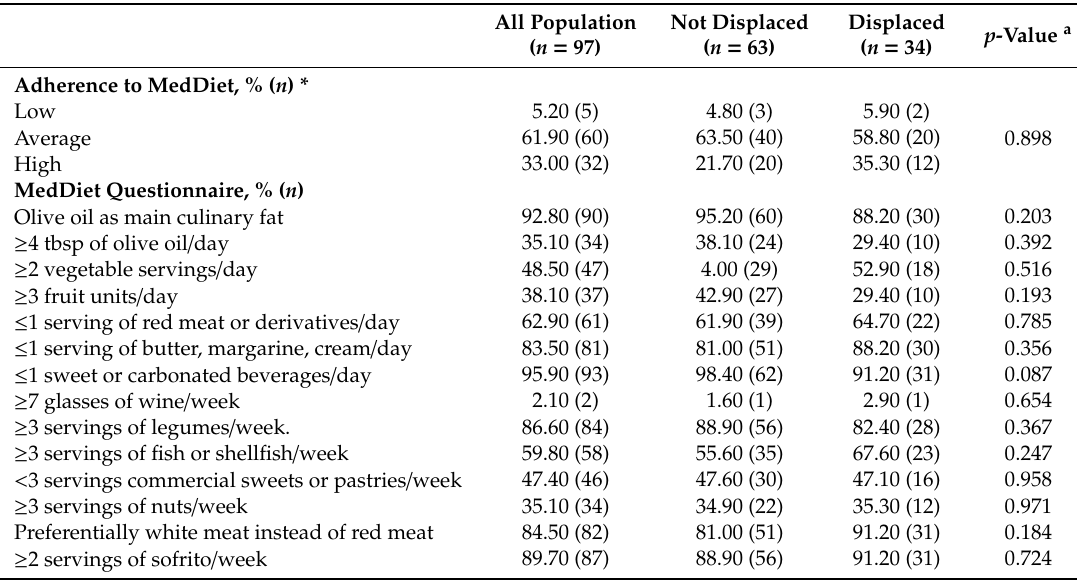
Table 4. Mediterranean diet adherence according to whether the university students are displaced from home or